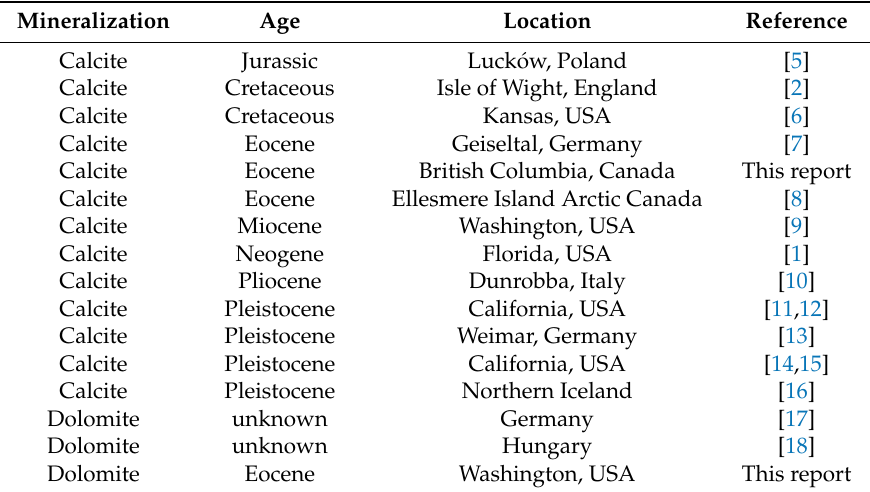
Table 1. Woods mineralized with carbonate